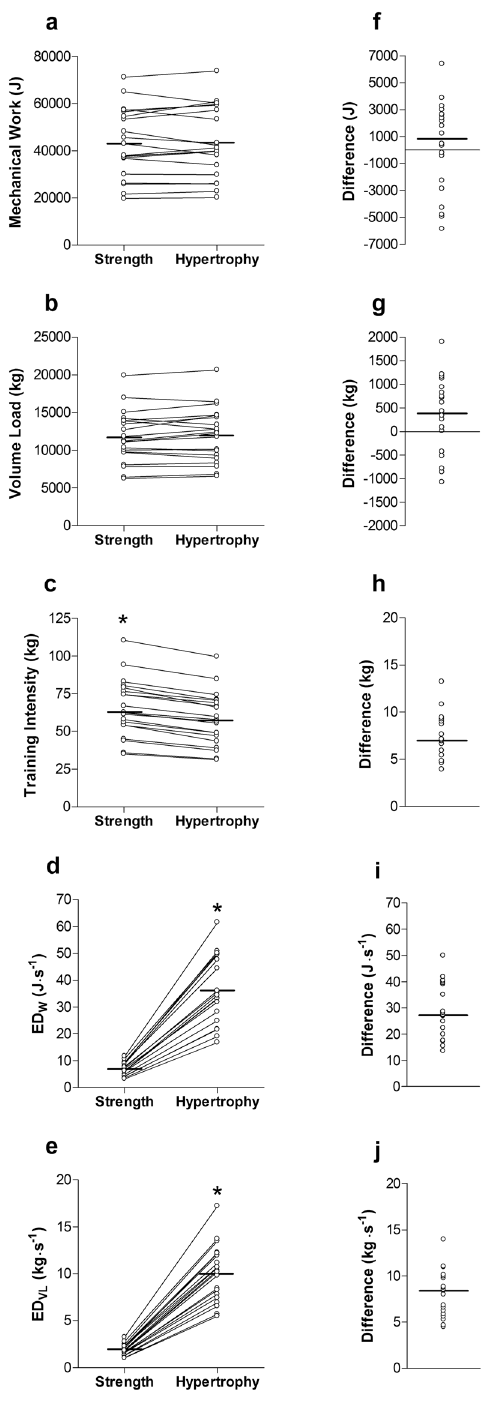
Figure 1. Paired comparisons between strength and hypertrophy conditions about the median ( − ) in ( a ) mechanical work, ( b ) Volume Load, ( c ) TI, ( d ) ED W and ( e ) ED VL . Pairwise differences in ( f ) mechanical work, ( g ) Volume load, ( h ) TI, ( i ) ED W and ( j ) ED VL . * Difference significant at p <